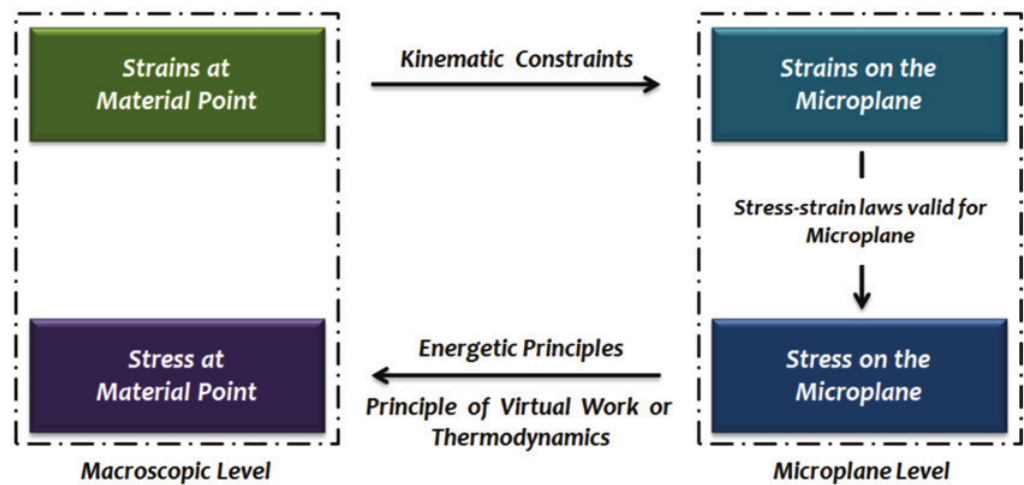
Synthesis of the microplane models formulation (Leukart